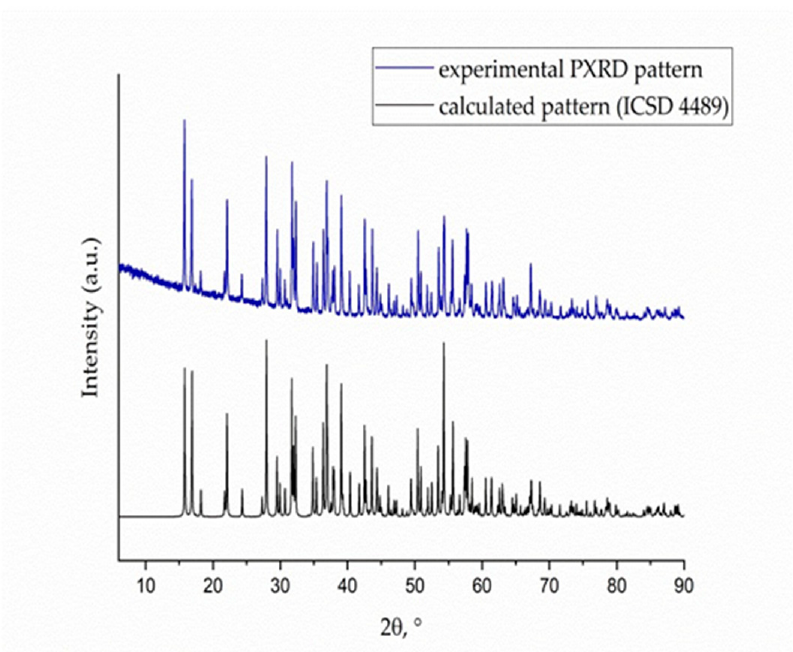
Figure 3. PXRD patterns for Yb:YMgB 5 O 10 (blue) and calculated from cif -file for YMgB 5 O 10 , ICSD 4489 (black).